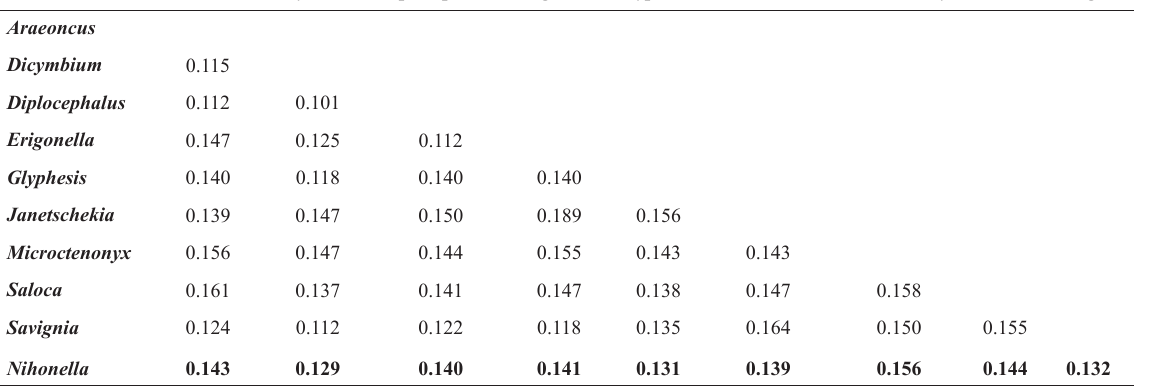
Table 2. Uncorrected Pairwise-distance between the genus Nihonella gen. nov. (in bold) and the main genera included in the Savignia group based on the barcode COI partial